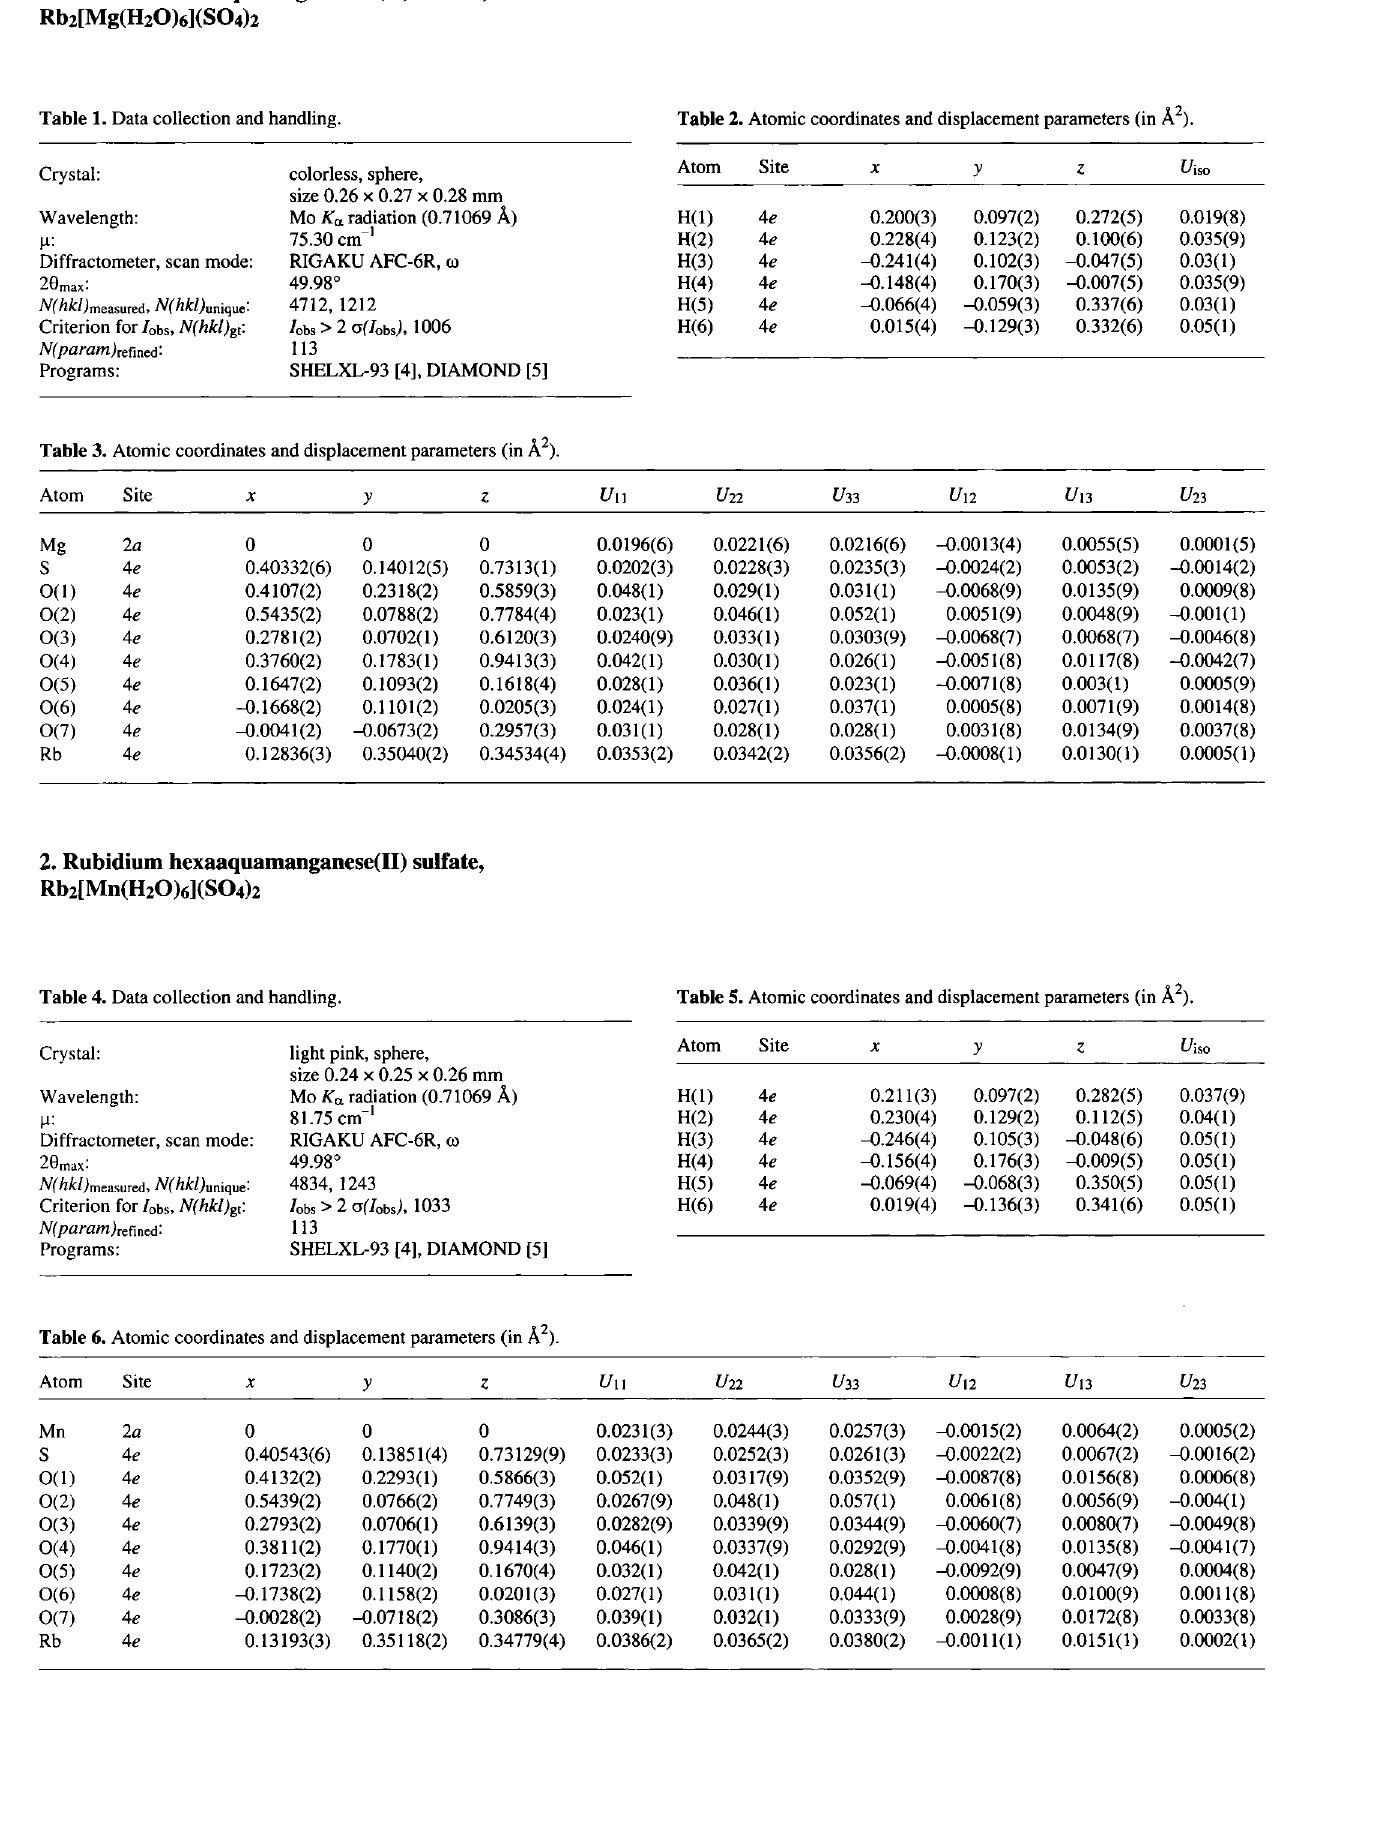
Table 1. Data collection and handling. Table 2. Atomic coordinates and displacement parameters (in A 2 ).